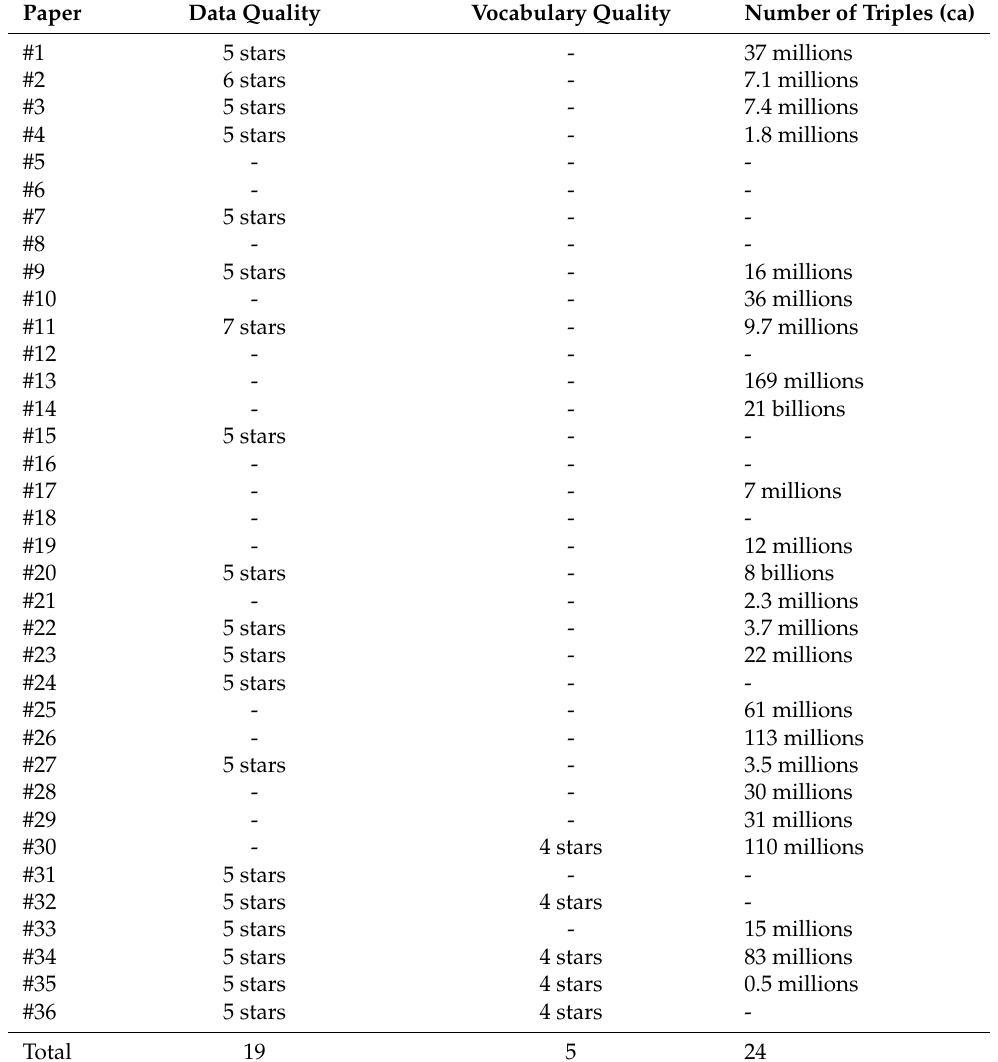
Table 2. Quality and size of the resulting knowledge